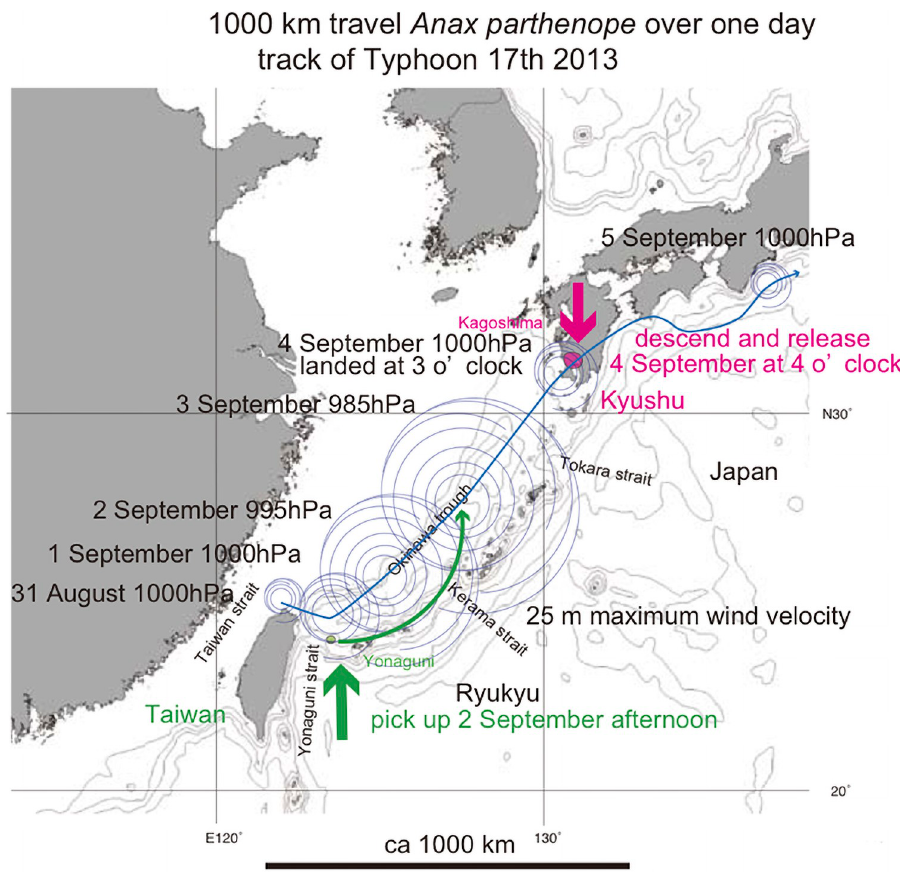
Fig 12. Track of Typhoon 17, 2013 (fine blue sinuous path), and hypothetical 1000 km transport of Anax parthenope over one day by typhoon winds (green curved anticlockwise path). The bold short arrows schematically (not to scale) show where the typhoon winds picked up cicada (green) and where the same cicada were released (red). Base map from Vector Map (VMap) Level 0, National Geospatial-Intelligence